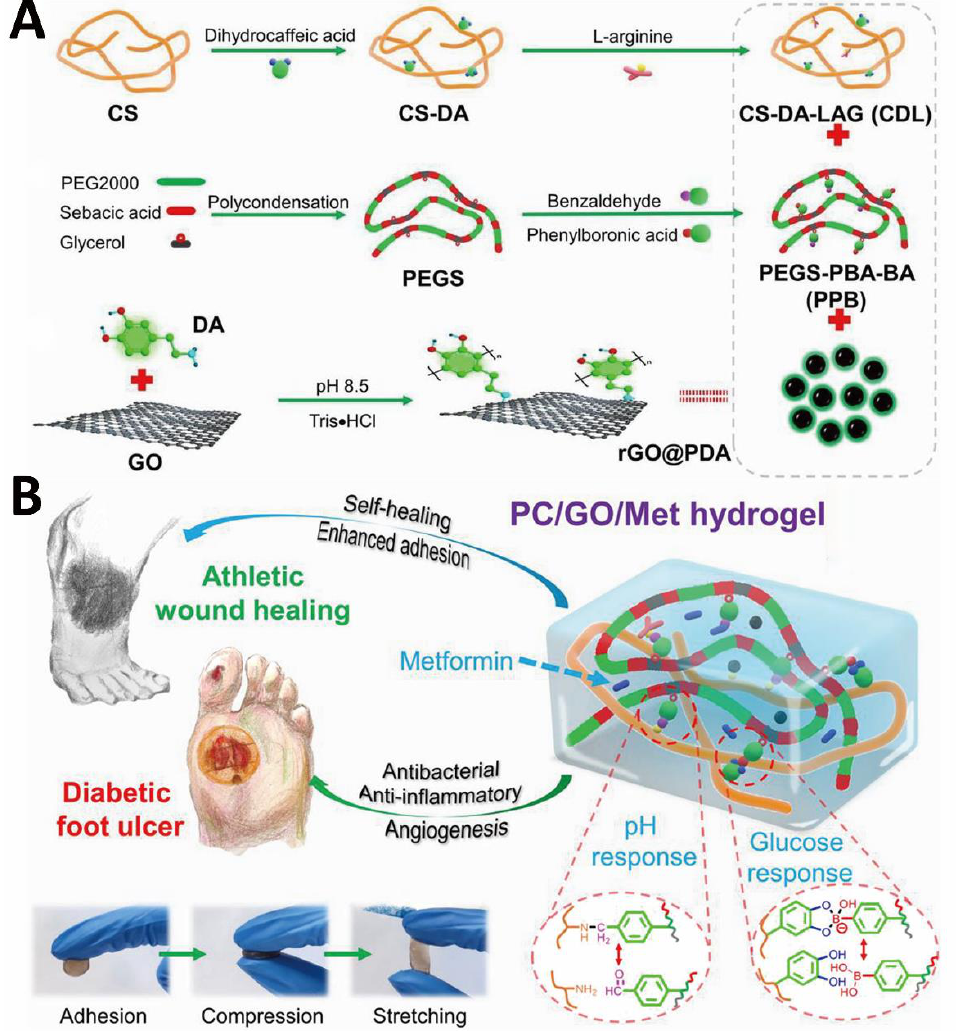
Figure 2. CS-based hydrogel bio-adhesive: schematic diagram of ( A ) preparation and ( B ) application of CS-based hydrogel bio-adhesive. Reprinted with permission from ref [90]. Copyright 2022 American Chemical Society.